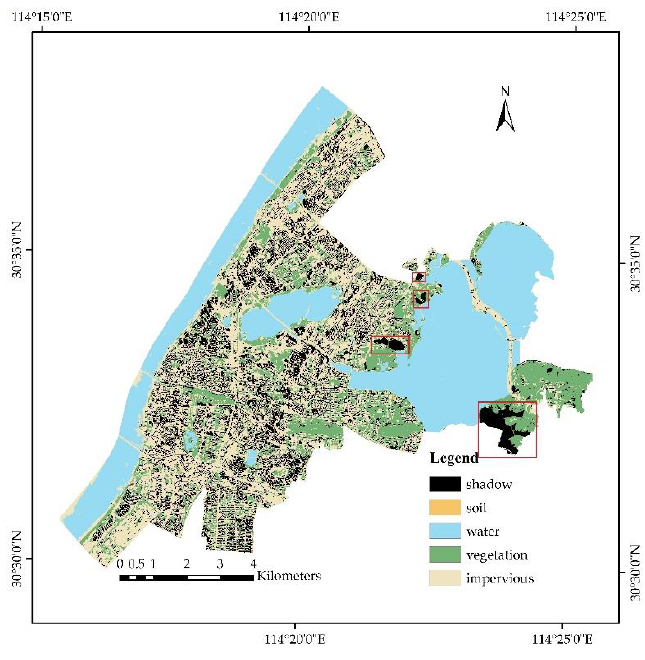
Figure 5. Land-cover map of Wuchang District. Table 4. Confusion matrix of the land-cover classification